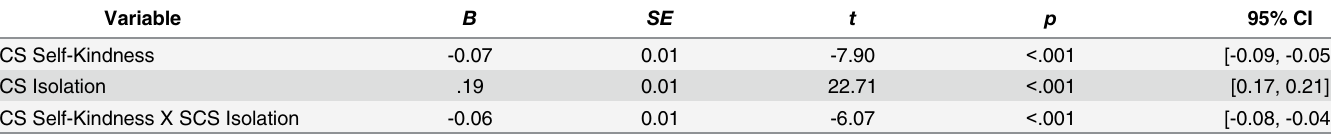
Table 5. Moderation of the Relationship Between Isolation and PHQ-9 by Self-Kindness (n = 2,362)